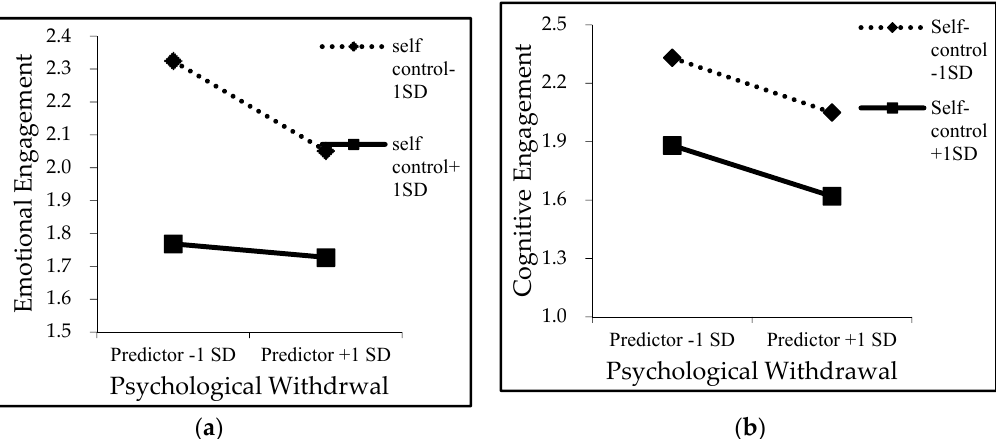
Figure 3. ( a ) Cross-level moderating effect of self-control on the relationship between emotional engagement and psycho- logical withdrawal. ( b ) Cross-level moderating effect of self-control on the relationship between cognitive engagement and psychological withdrawal.